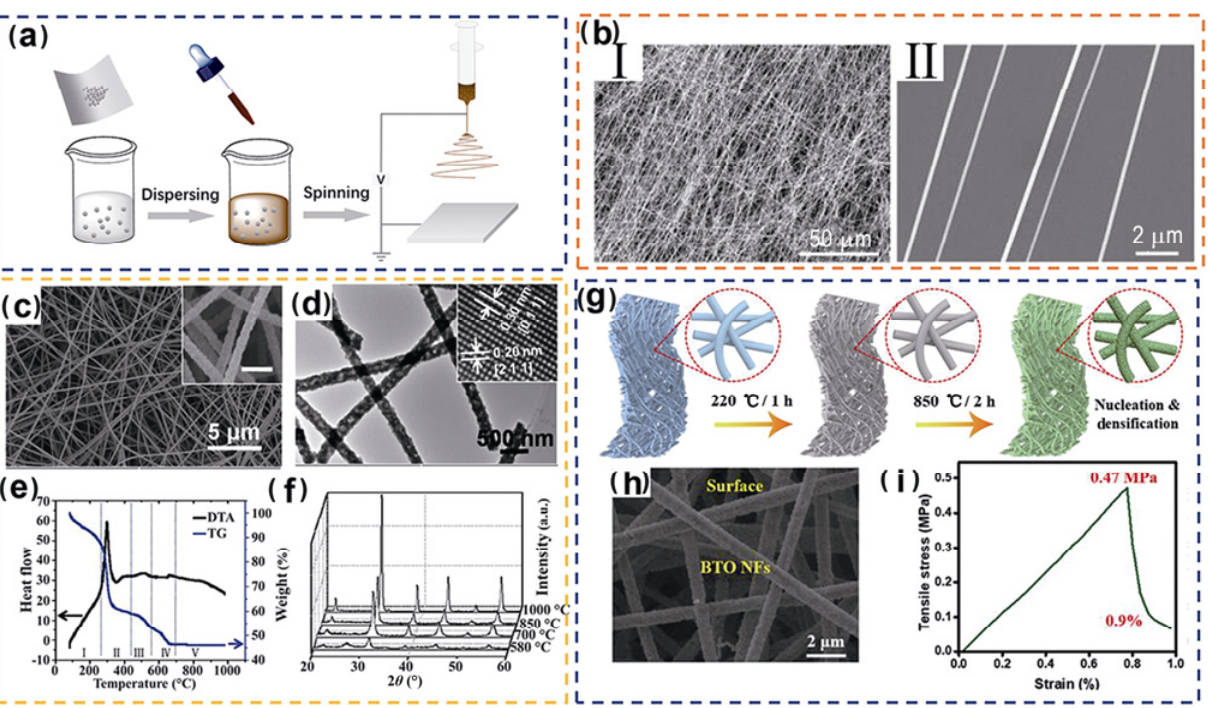
Fig. 5 (a) Schematic diagram of electrospinning process. (b) SEM images of PMN–PT nanofibers. (c) Low-magnification SEM images and (d) TEM images of sintered BZT–BCT NWs. (e) Thermogravimetric analysis (TGA) and differential